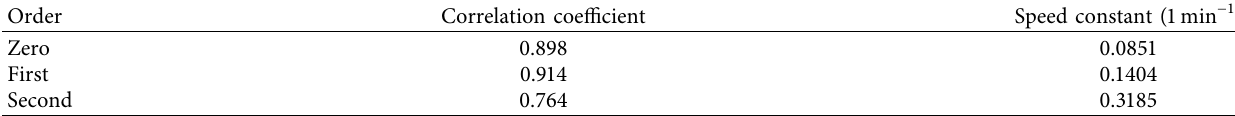
Table 4: Correlation coefcient values of adsorption rate equations for TWMNPs.